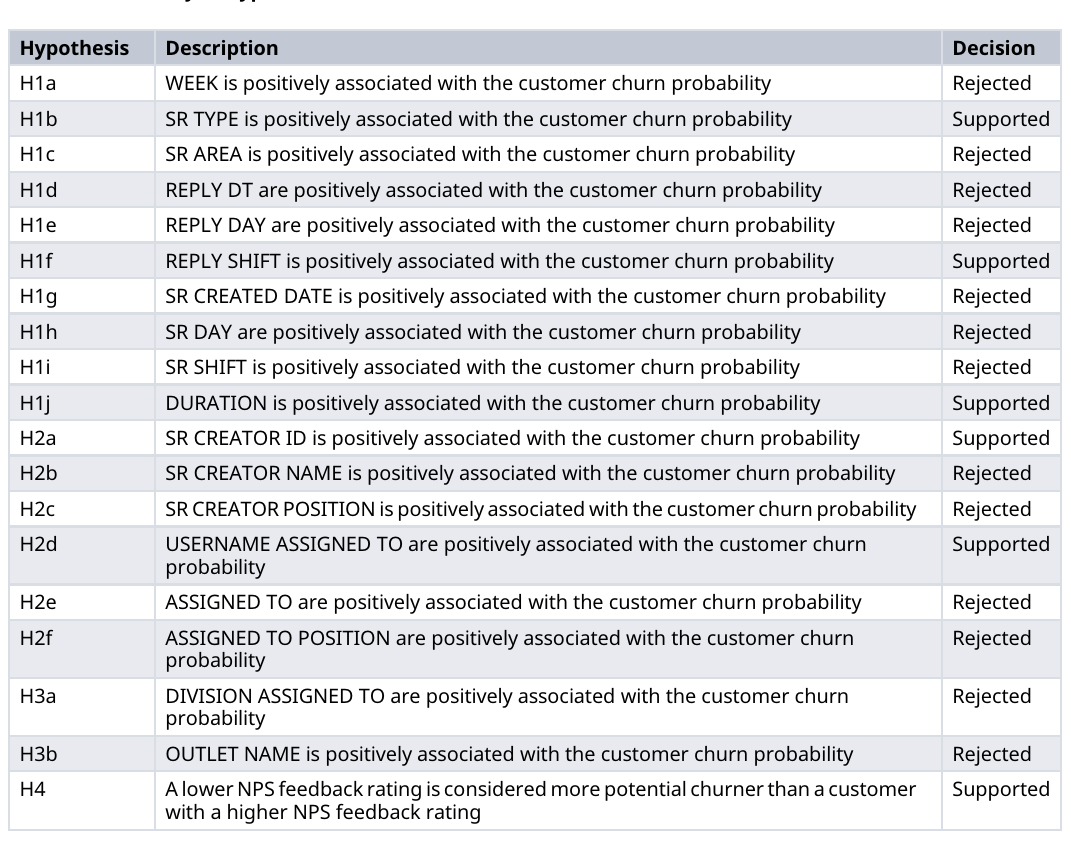
Table 15. Summary of hypothesis